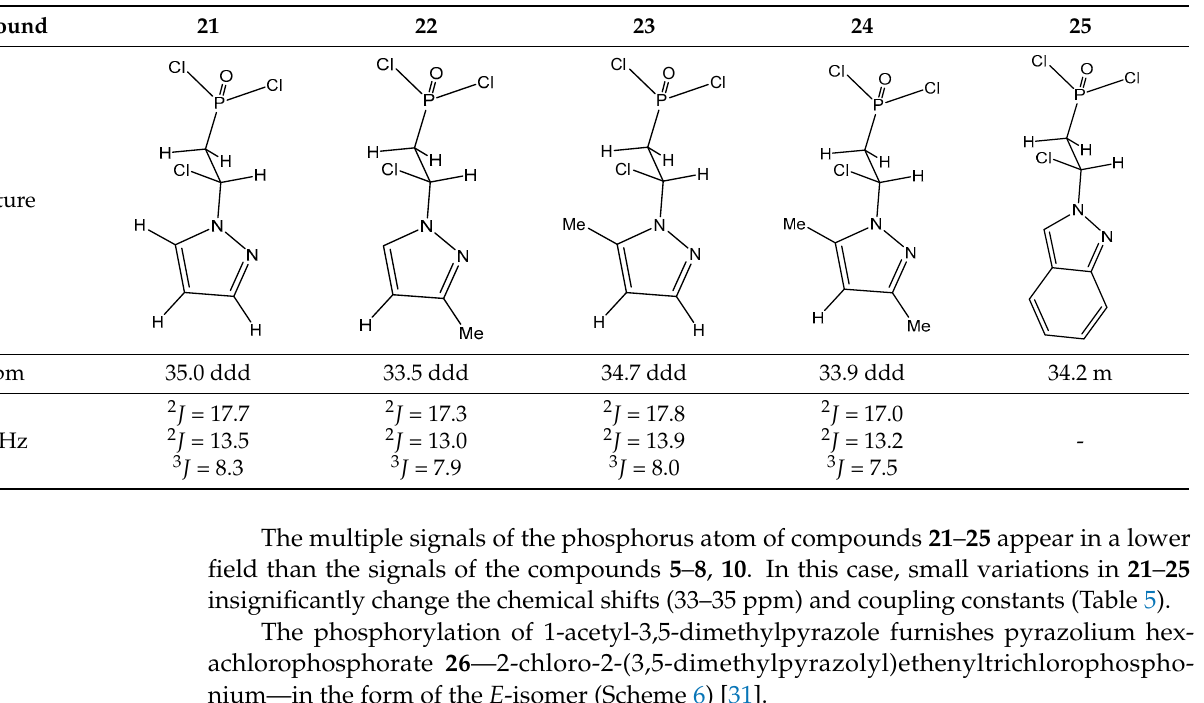
Table 5. 31 P NMR chemical shifts ( δ , ppm) and coupling constants ( J , Hz) of hydrochlorated products of azolylphosphonic dichloroanhydrides ( 21 – 25 ).